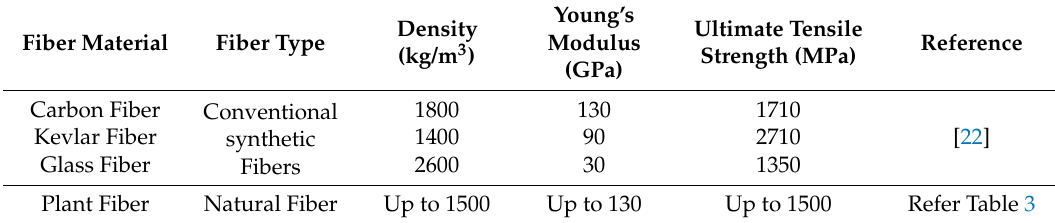
Table 4. Comparison of specific properties between conventional synthetic fibers and plant fibers.